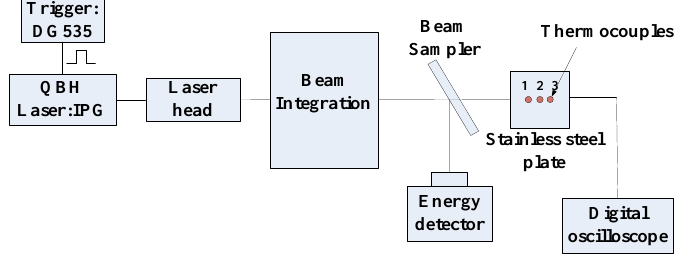
Figure 13. Laser radiation heating system.